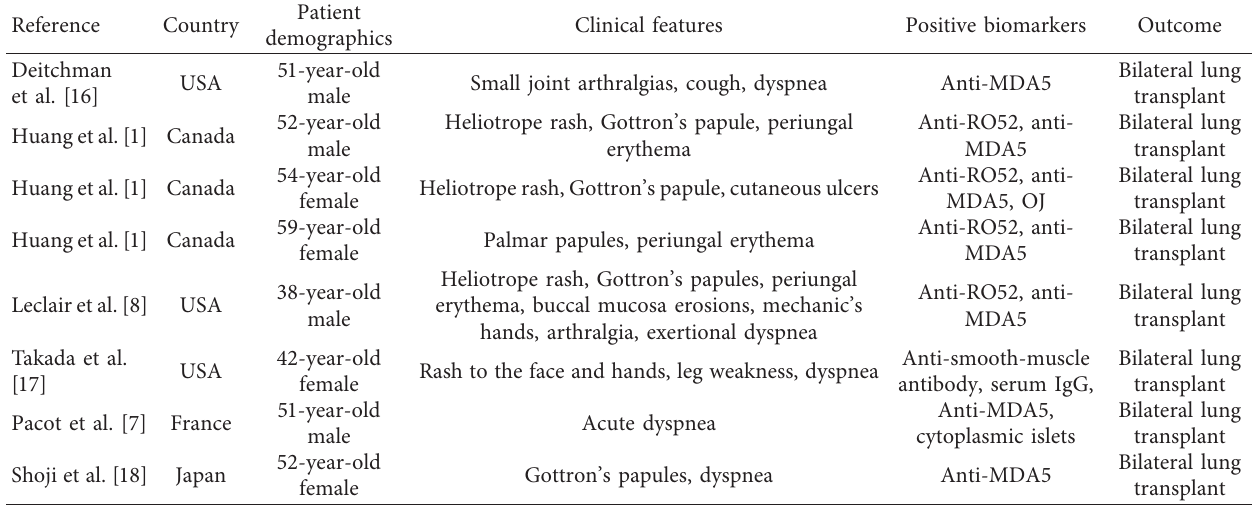
Table 1: Lung transplant rescue therapy in MDA5-RPILD case